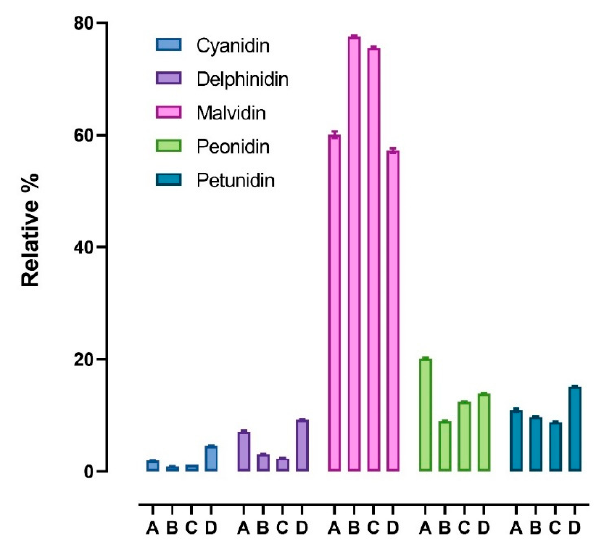
Figure 4. Relative percentages of anthocyanin aglycones (cyanidin, delphinidin, malvidin, peonidin, and petunidin) found in the four samples (A, B, C, D). Data are reported as mean ± SD.